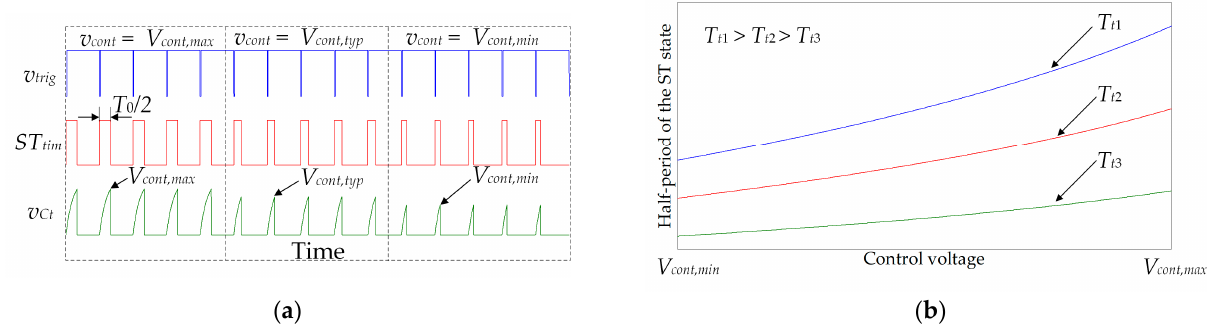
Figure 6. Waveforms of the trigger voltage, STS signal generated by the timer, and voltage of C t ( a ), Half-period of the STS as a function of the control voltage ( b ).